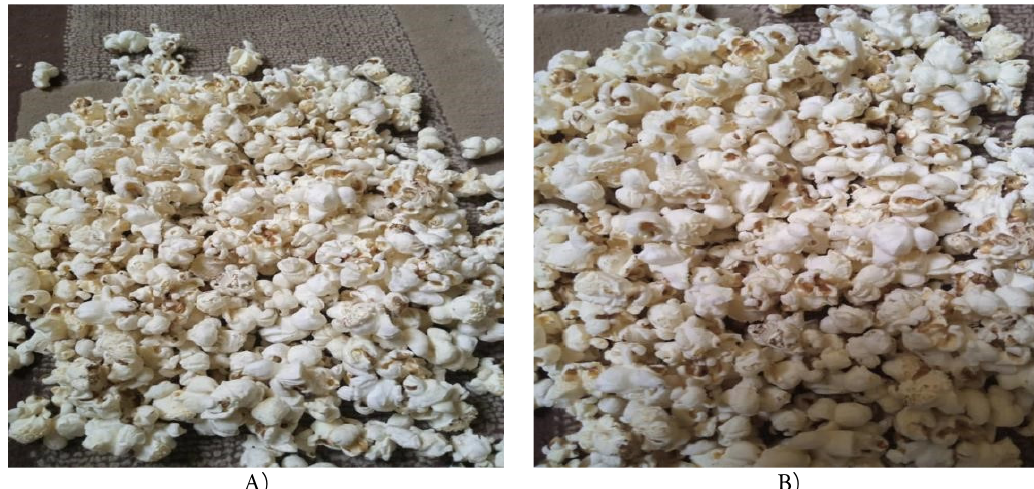
Figure 7. Popped volume of the popcorn by NMW (A); Popped volume of the popcorn by MTIW